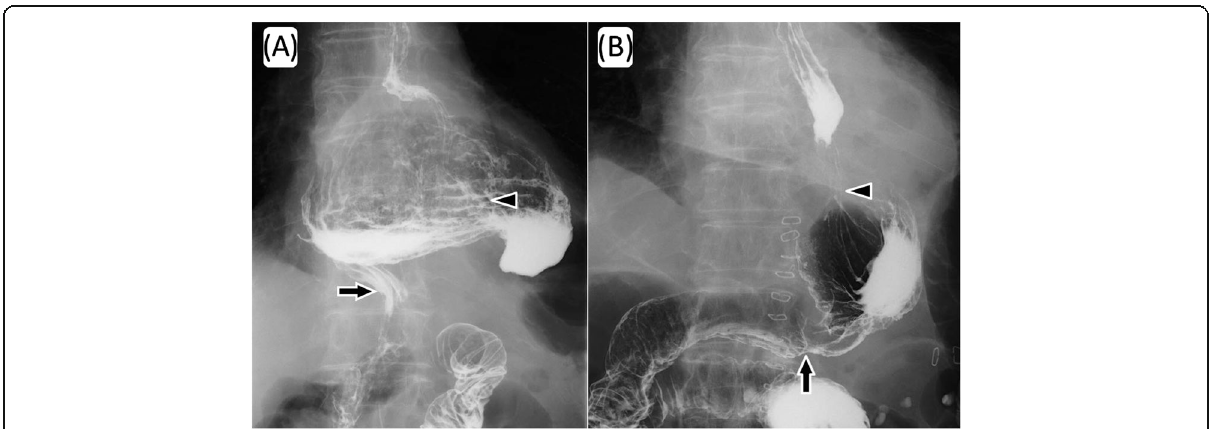
Fig. 1 Upper gastrointestinal examination. The intrathoracic postoperative stomach with delayed barium passage was observed ( a ). Postoperative examination on day 2 after repair of the hiatal hernia shows the stomach located in the normal position and the absence of any obstruction and reflux of barium through the gastroesophageal junction ( b ). Arrow heads indicate gastroesophageal junction and arrows indicate gastroduodenal anastomotic site